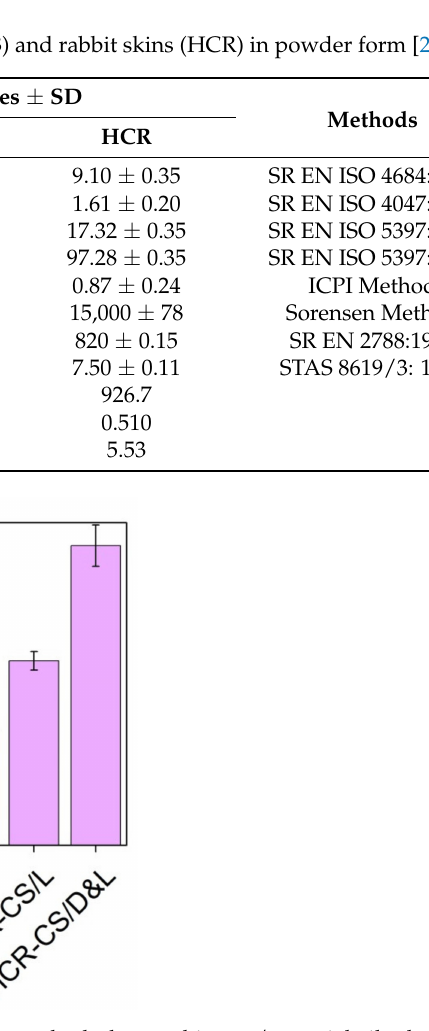
Figure 2. The concentration of EOs found in collagen hydrolysate-chitosan/essential oils electrospun